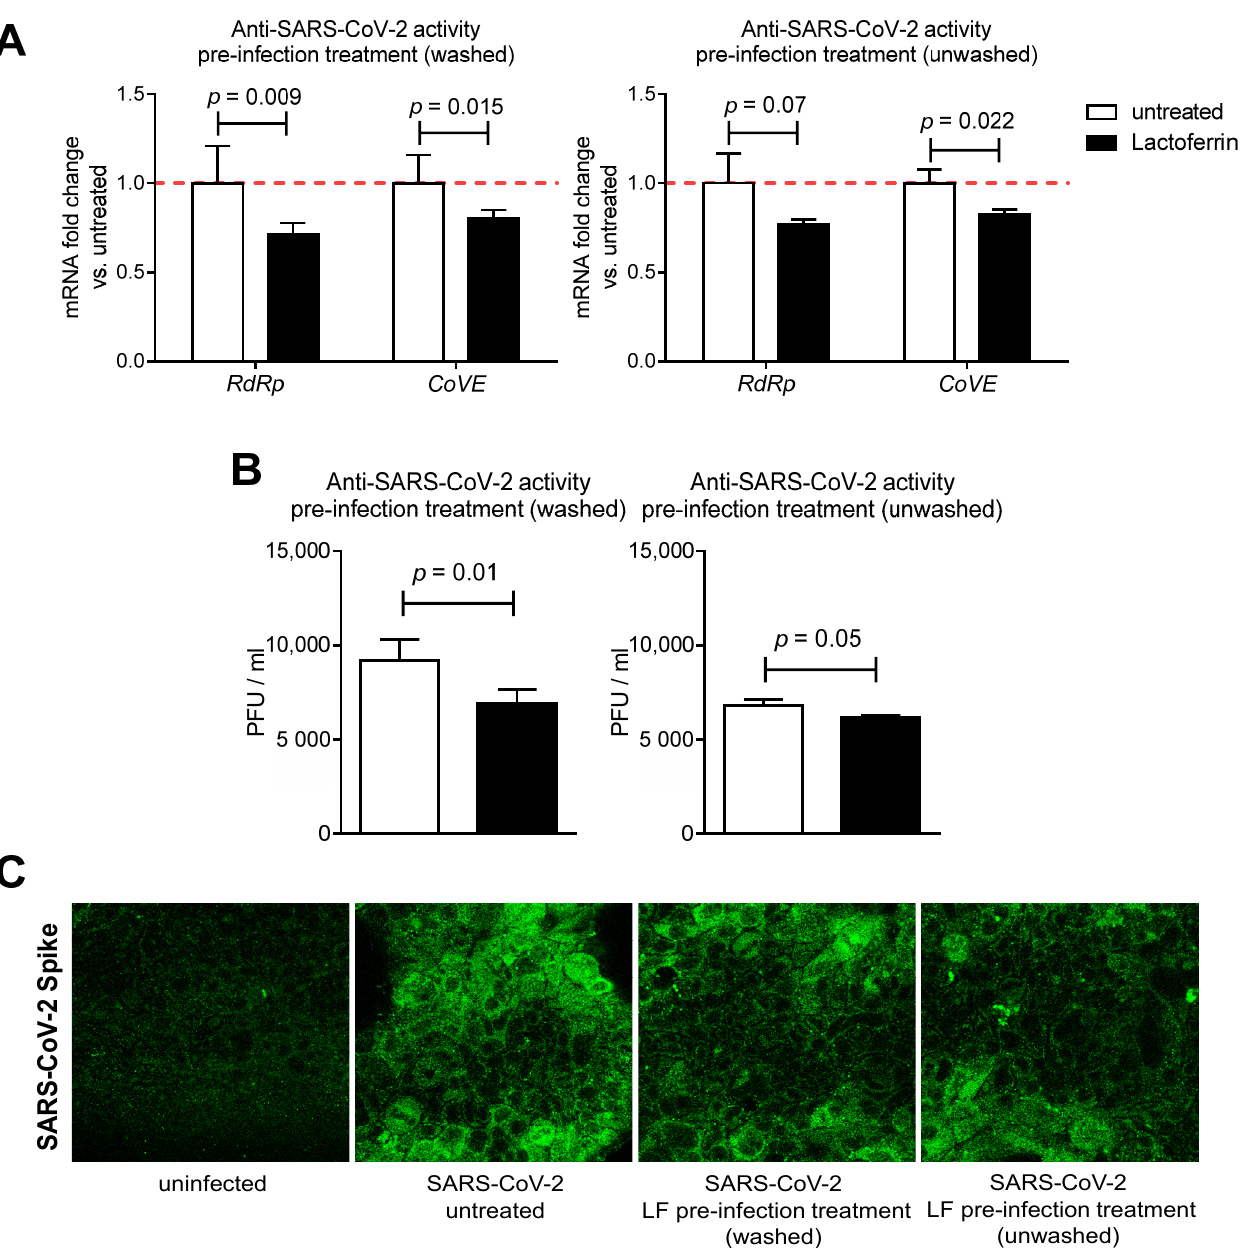
Figure 3. Lactoferrin protects intestinal epithelial cells from SARS-CoV-2 infection in vitro . ( A ) Caco-2 cells were treated or not for 3 h with 100 µg/mL lactoferrin and then infected with SARS-CoV-2 according to experimental design shown in Figure 1. SARS-CoV-2- specific gene expression was assessed by real-time qPCR 24 h post infection (n = 3–6). Data are shown as relative fold changes compared to untreated (arbitrarily set as 1). ( B ) SARS-CoV-2 titer was determined by plaque assay performed on harvested supernatants (n = 4). Data are presented as mean + SD. ( C ) Representative staining for SARS-CoV-2 spike of infected Caco-2 cells pre-treated or not with lactoferrin according to experimental design shown in Figure 1.